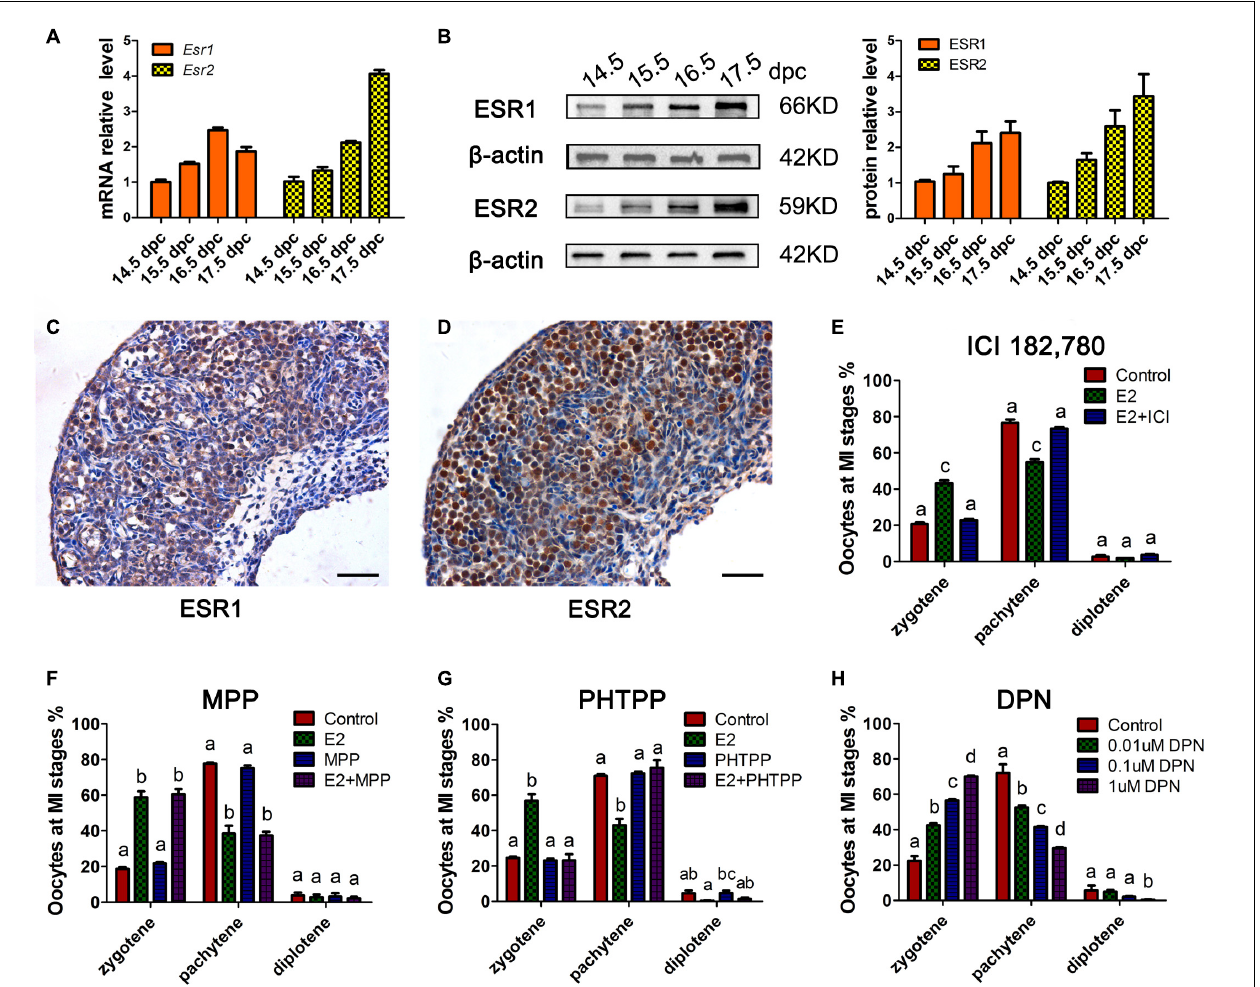
FIGURE 2 | ESR2 regulates meiotic prophase I of fetal oocytes. The mRNA (A) and protein (B) expressions of ESR1 and ESR2 in the developing fetal ovary. The distribution of ESR1 (C) and ESR2 (D) in 15.5 dpc ovary by IHC. ICI 182,780 (E) and PHTPP (G) recovered the delaying effect of E 2 on MPI. (F) MPP didn’t affect the delaying effect of E 2 on MPI. (H) DPN delayed the MPI progression. Different letters: P <